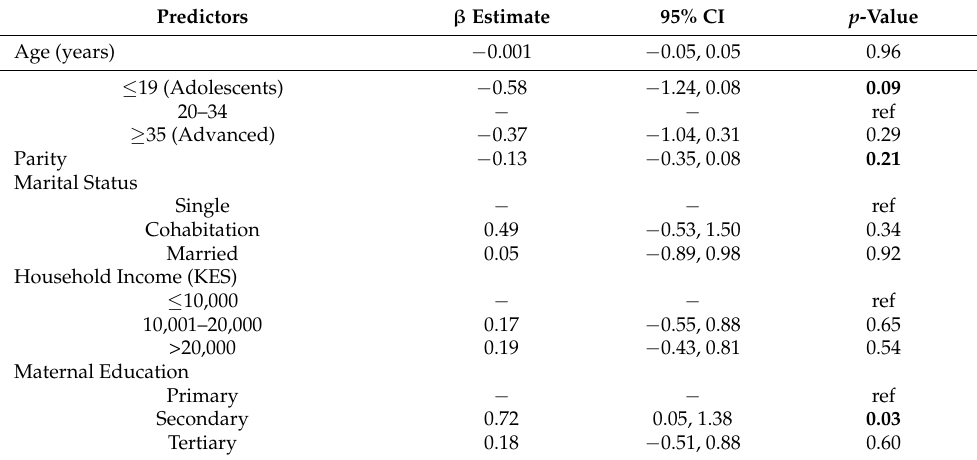
Table A2. Results of bivariate analysis between socio-demographic predictors and hair cortisol concentration